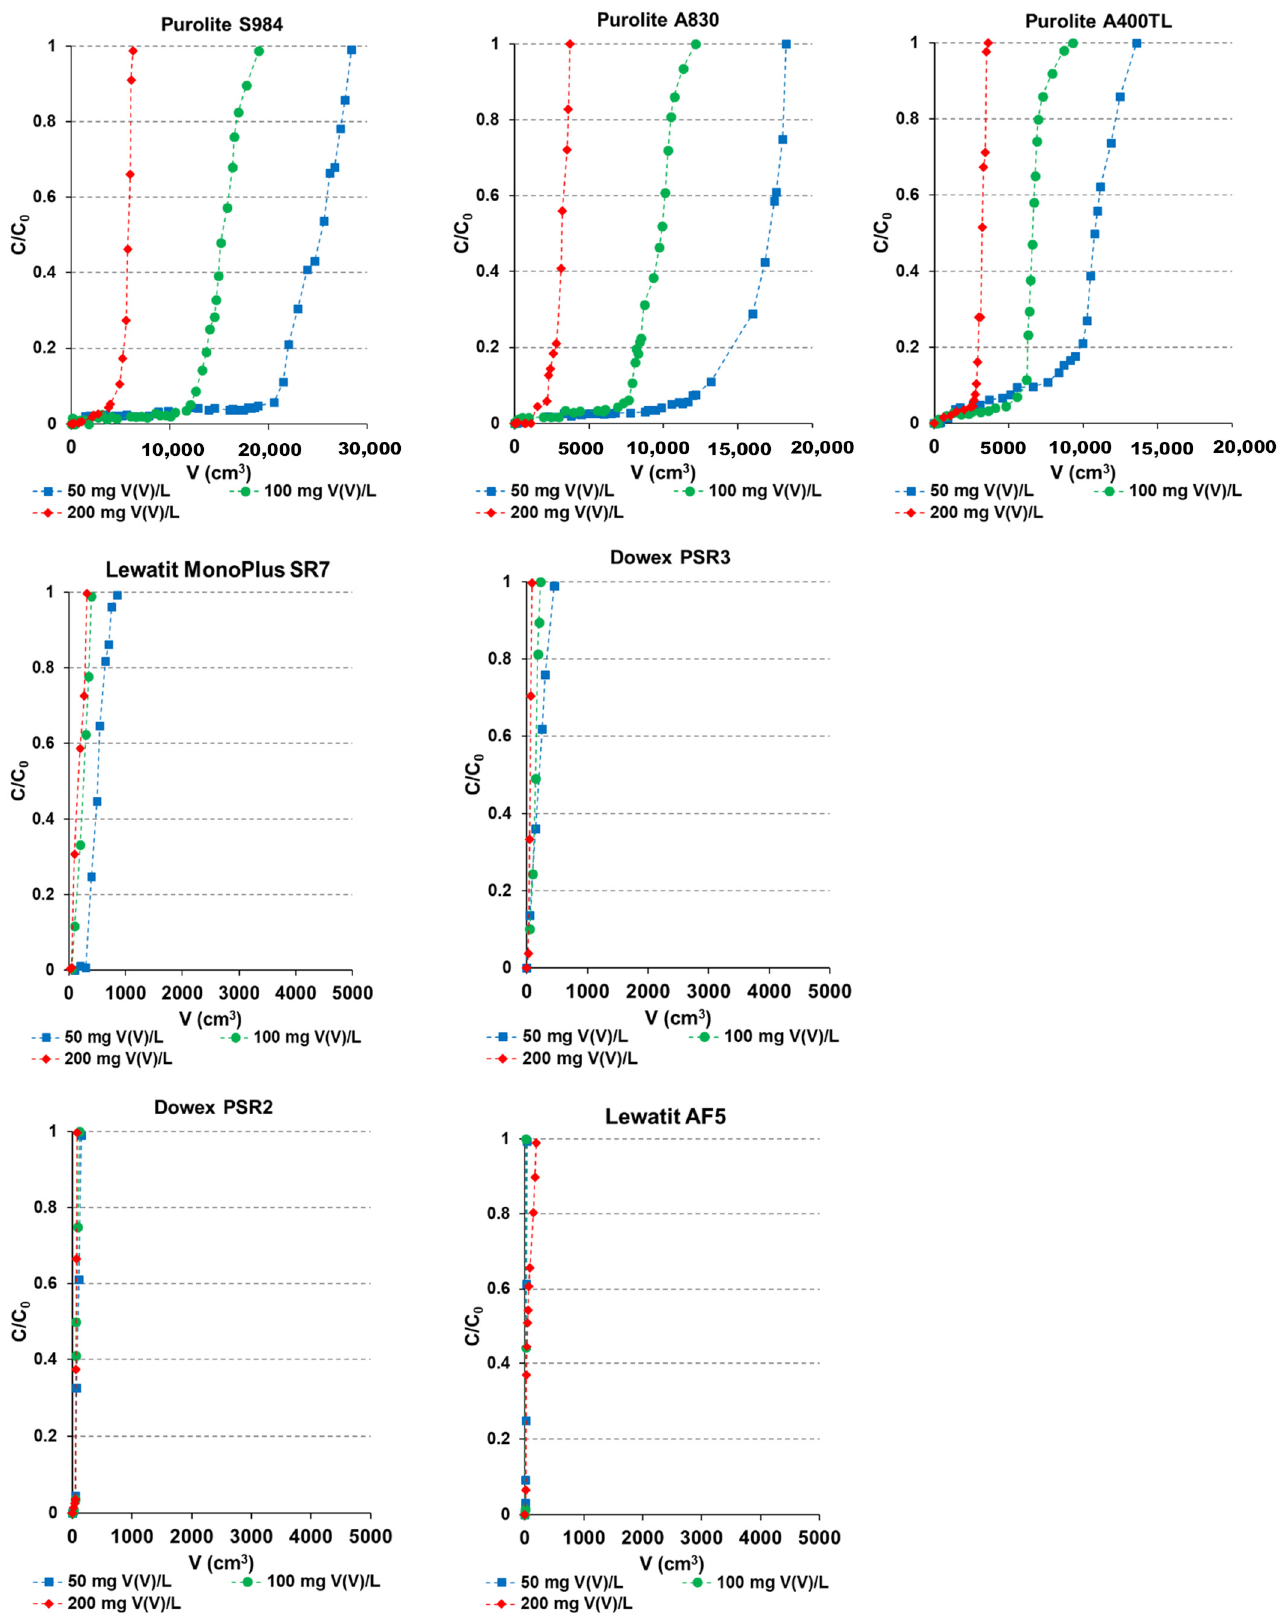
Figure 11. Breakthrough curves obtained during the adsorption of vanadium by the column studies.